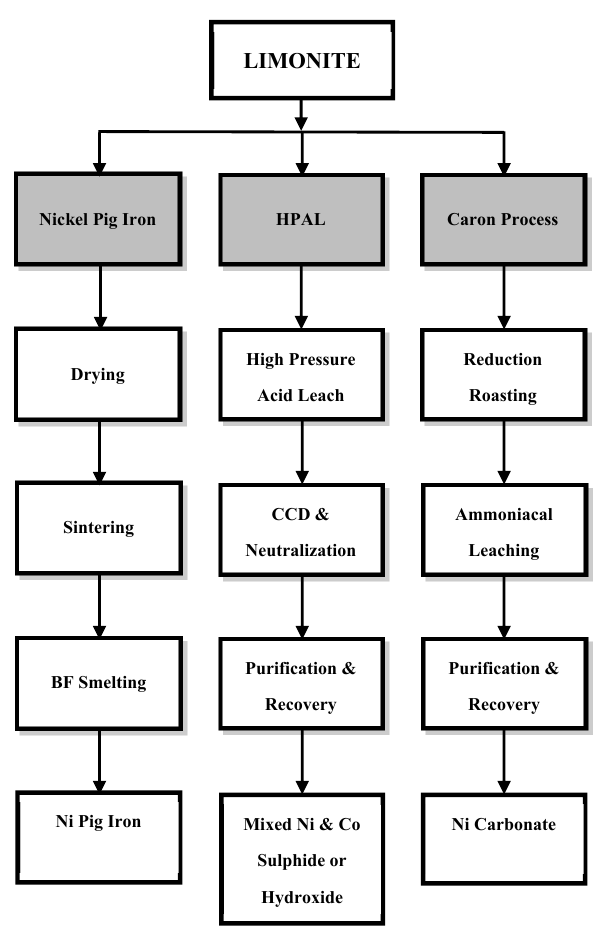
Figure 1: Simplified flowsheet of the current commercial production methods for the extraction of nickel from the nickeliferous limonitic laterite ores, adapted from previous work by Dalvi et al. [1].